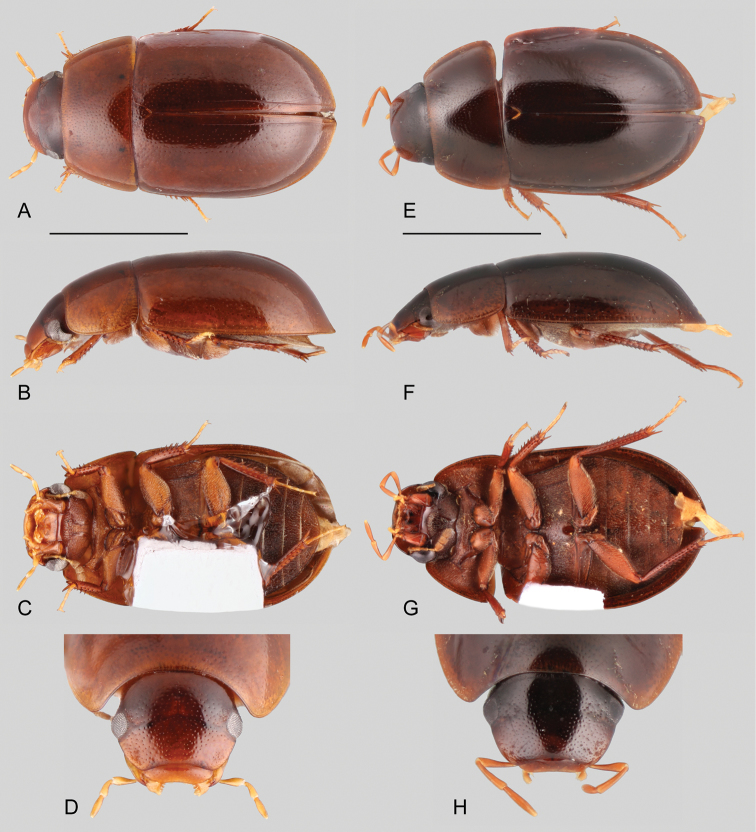
Habitus of Primocerus spp.: A–DPrimoceruscuspidis: A dorsal view B lateral view C ventral view D head, dorsal view. E–HPrimocerusneutrum: E dorsal view F lateral view G ventral view H head, dorsal view. Scale bars: 1 mm.